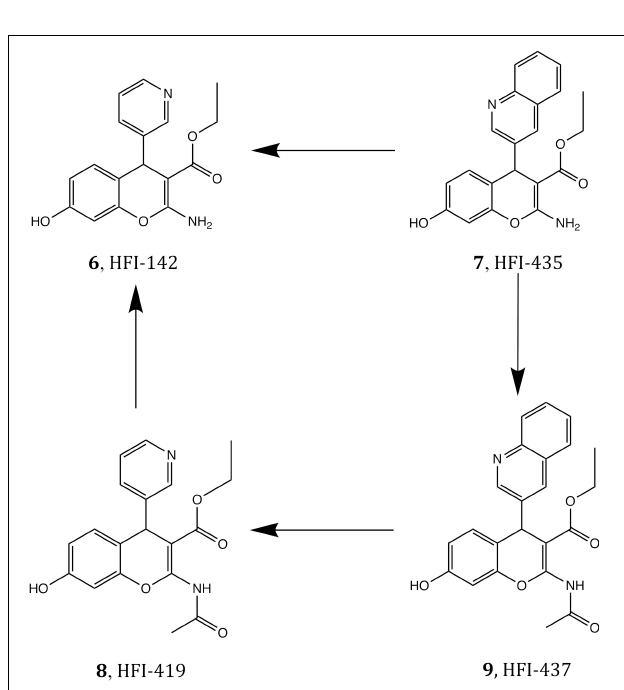
FIGURE 5 | Closed thermodynamic cycle depicting the FEP pair transformations that connect the four compounds 6–9.